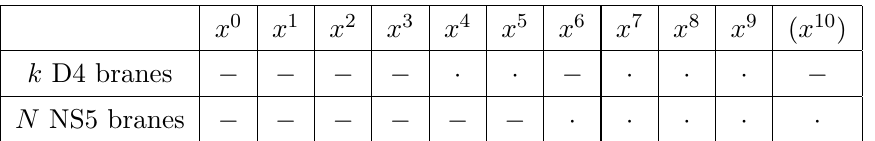
Table 2 . Brane configuration in type IIA string theory. The direction x 6 is compact with periodicity x 6 → x 6 + 2 πR 5 . The coordinate x 10 parametrises the M-theory circle at strong coupling with periodicity x 10 → x 10 + 2 πR 6